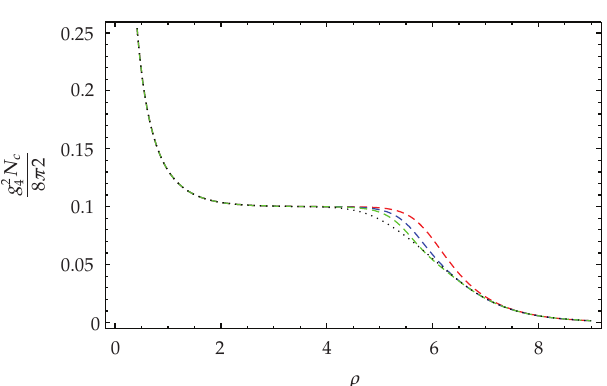
Figure 7: The ’t Hooft coupling g 2 N c / (cid:5) 8 π 2 (cid:6) as a function of ρ for N c (cid:8) 10, c (cid:8) 100, and α (cid:8) 0 . 0005 for 4 (cid:5) iii (cid:6) . The red (cid:5) long dashes (cid:6) curve is the O (cid:5) c (cid:6) approximation in the expansion of (cid:5) 5.15 (cid:6) , the blue (cid:5) medium dashes (cid:6) line is the O (cid:5) 1 /c (cid:6) approximation, the green (cid:5) short dashes (cid:6) line is the O (cid:5) 1 /c 3 (cid:6) approximation,